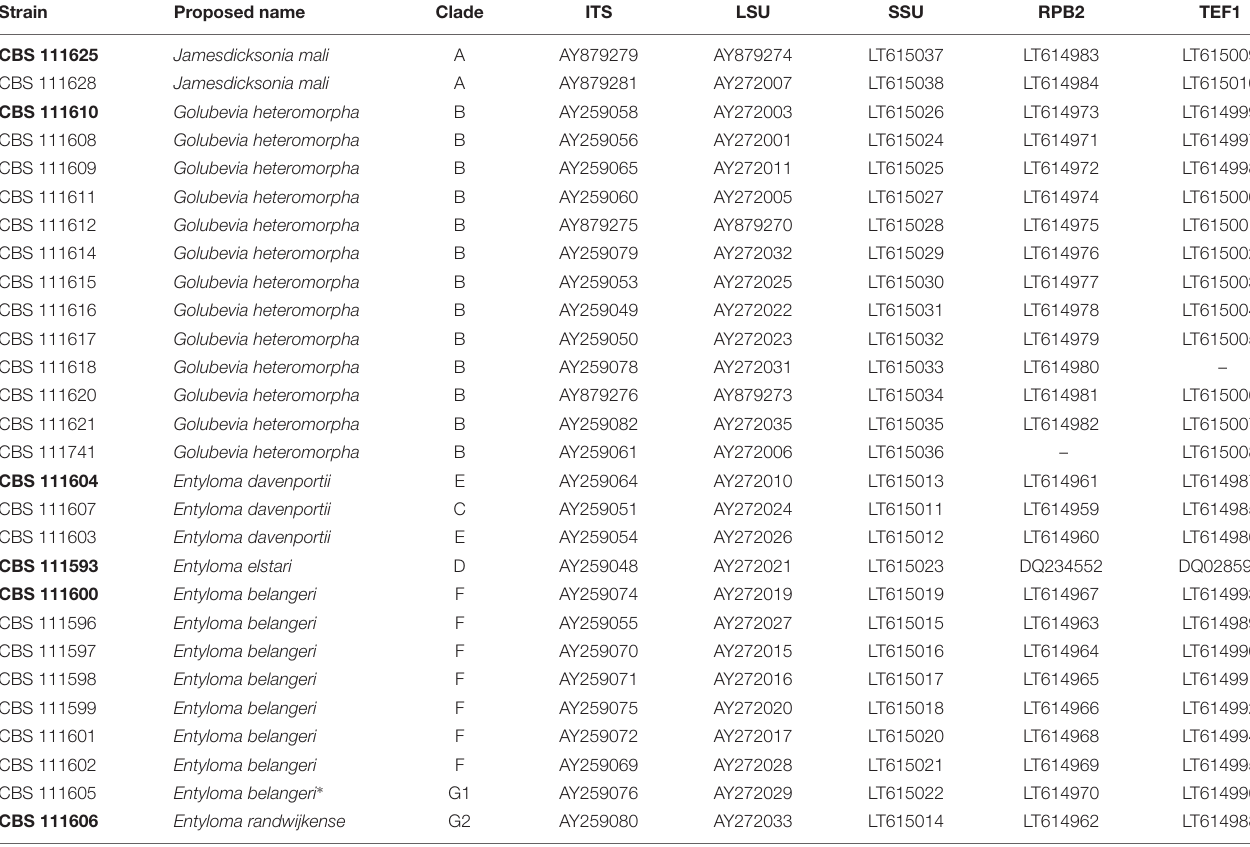
TABLE 1 | Strains and GenBank accession numbers of new species, proposed type strains in